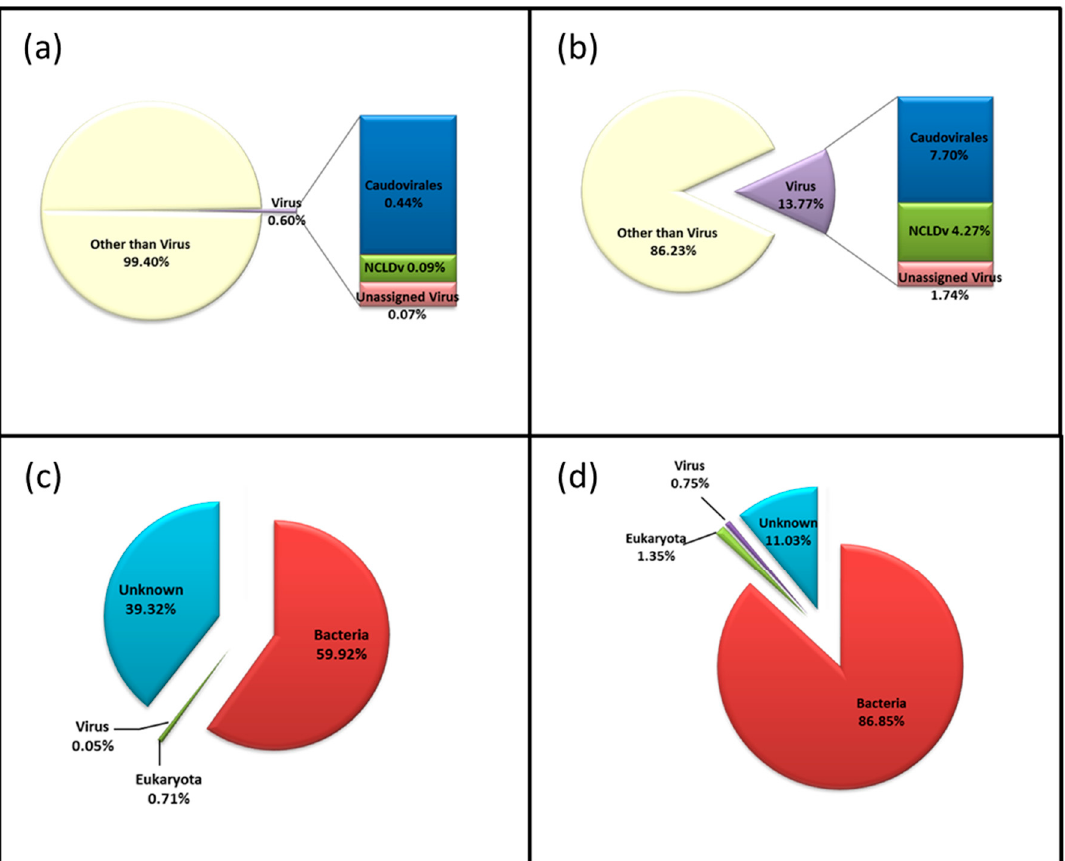
Figure 4. Taxonomic assignment based on reads ( a , c ) and contigs ( b , d ) analyses. Reads (R1) were annotated using ( a ) the Virus database and ( c ) the Refseq database; contigs were annotated using ( b ) the virus database and ( c ) the Refseq nr ‐ protein database.